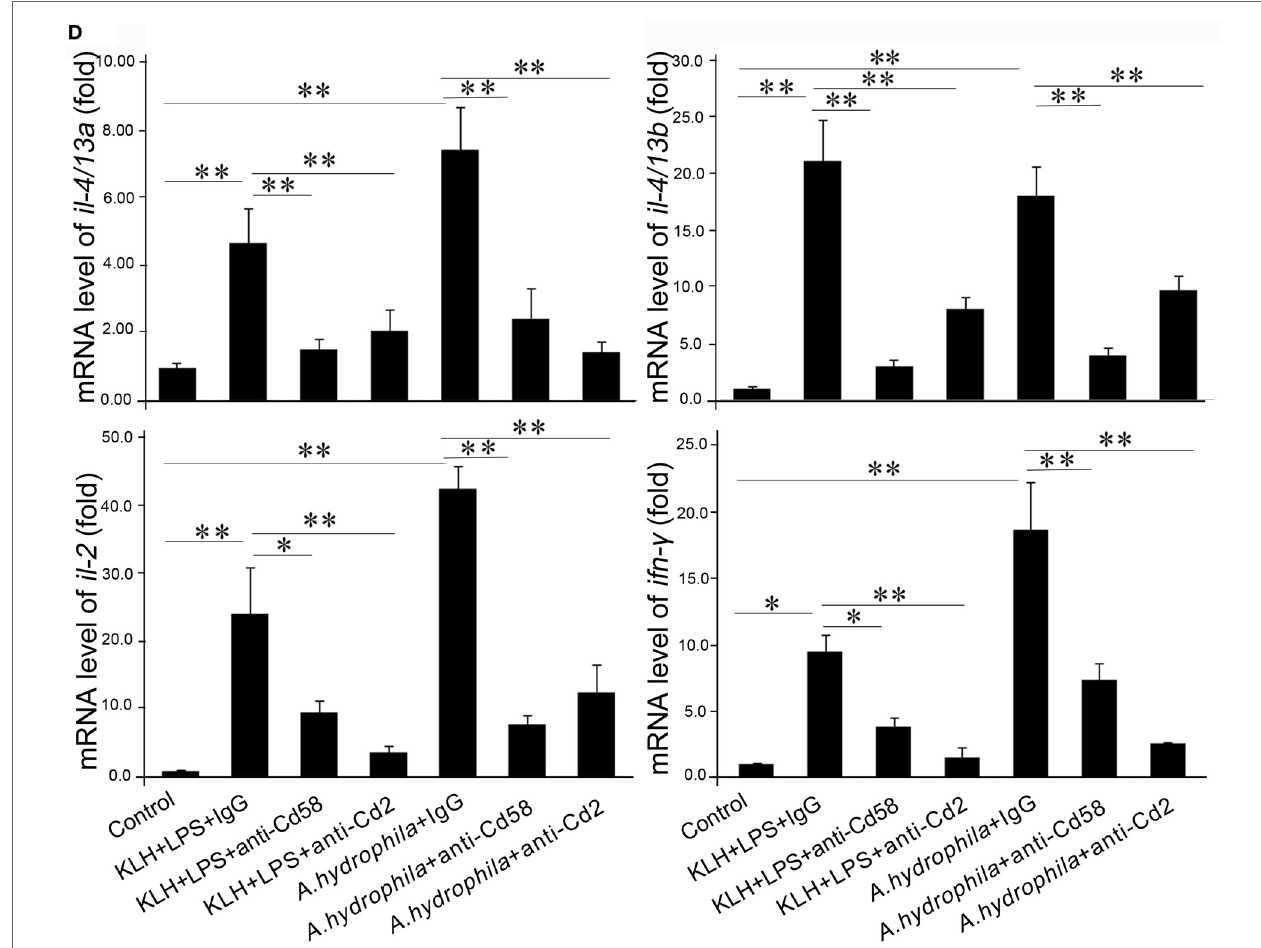
FigUre 7 | In vitro evaluation of Cd58 and Cd2 in APC-initiated Cd4 + T cell proliferation. The proliferation of Cd4 + T KLH (a) or Cd4 + T A.h (B) was inhibited by treating the cells with anti-Cd58 or anti-Cd2 antibodies, determined by CFSE dilution through flow cytometry and by the expression levels of lck and cd154 (c) and cytokines ( il-4/13a, il-4/13b, il-2 , and ifn- γ ) production (D) through real-time PCR. Cd4 + T KLH cells or Cd4 + T A.h co-cultured with PBS-loaded primary APCs were used as control. Error bars represent SE. All data were from at least three independent experiments (* p < 0.05, ** p <